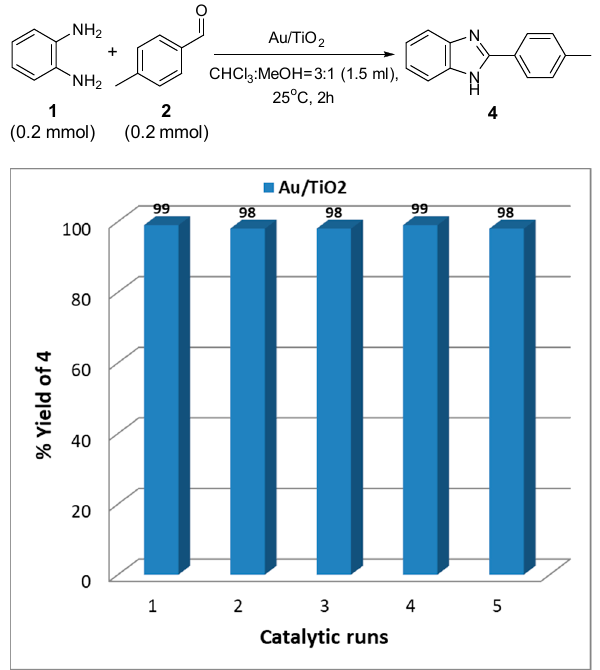
Figure 2. Catalytic runs using the Au / TiO 2 catalyst. Experimental conditions: 40 mg of the catalyst, 0.2 mmol of 1 , 0.2 mmol of 2 , 1.5 mL of CHCl 3 :MeOH (3:1), 25 °C, t = 2 h.